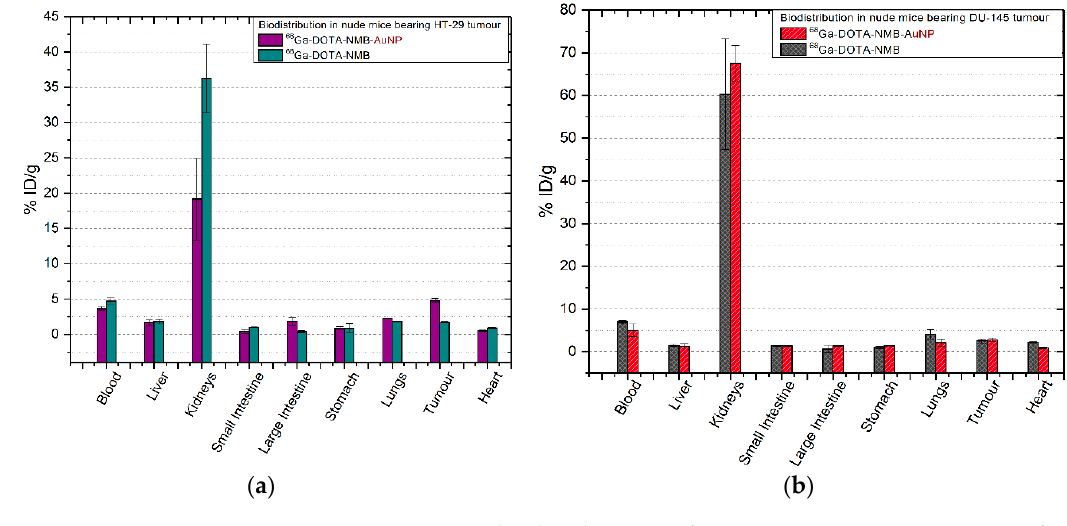
Figure 6. Comparative ex vivo biodistribution after 30 min post-injection of 68 Ga-DOTA-NMB / 68 Ga-DOTA-NMB-AuNP: ( a ) in nude mice bearing colon tumour; ( b ) in nude mice bearing prostate tumour. Data are presented as mean ± SD ( n = 4).